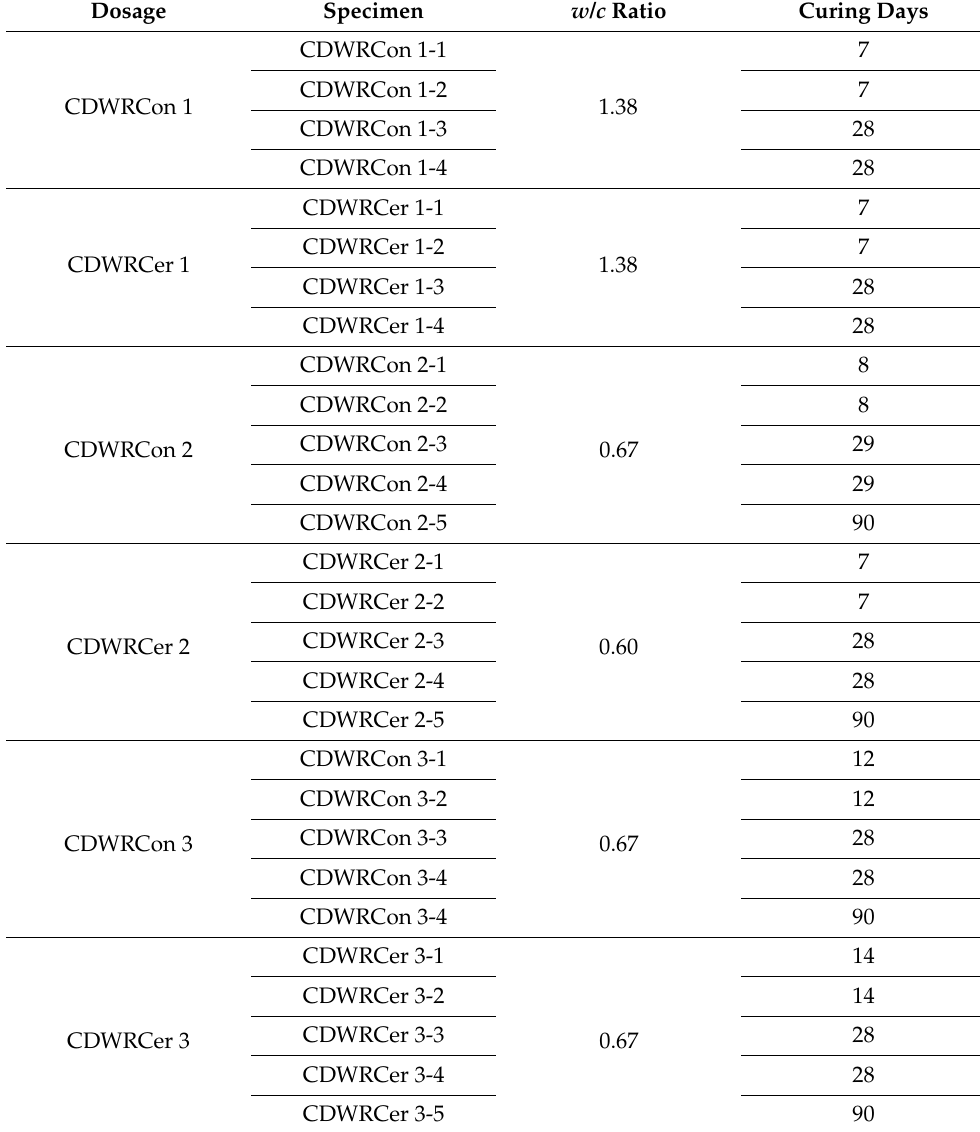
Table 5. Typology and characteristics of the tested